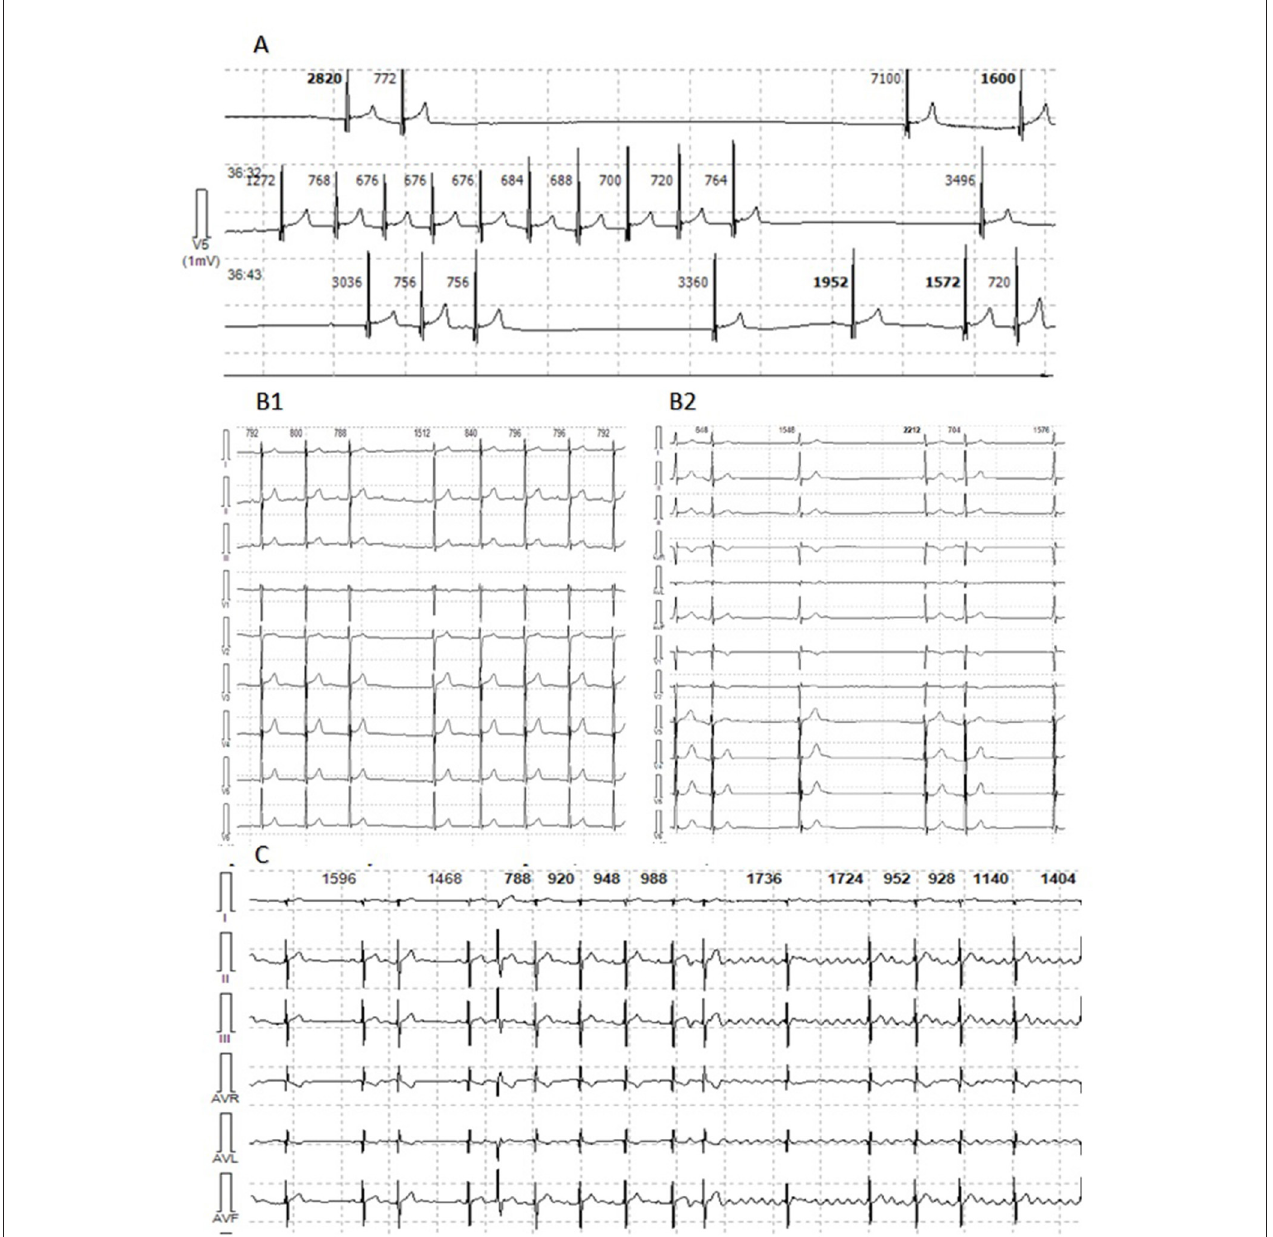
FIGURE 2 | Holter monitor fragments of Patient 1, 2, and 5. (A) Patient 1. Sinus arrest with pauses from 3,036 to 7,104ms. (B1) Patient 2. Episode of sustained AT with variable AV conduction. (B2) Patient 2. Multifocal PACs. (C) Patient 5. Episodes of multifocal PACs, AT and AFib with variable AV conduction.